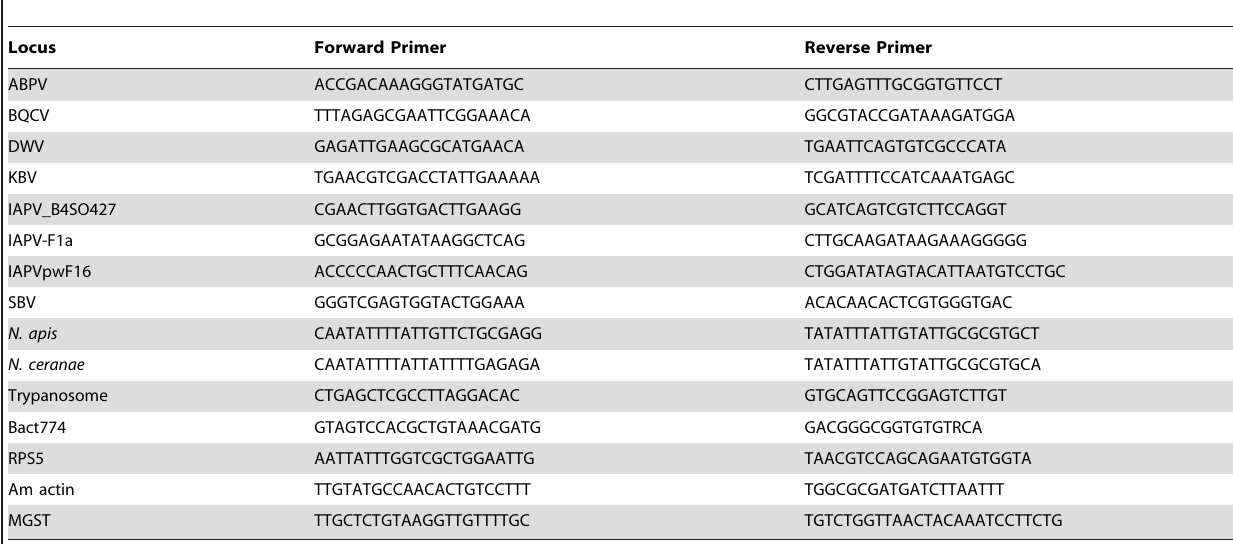
Table 1. Quantitative-PCR primers for measuring transcript abundances of honey bee